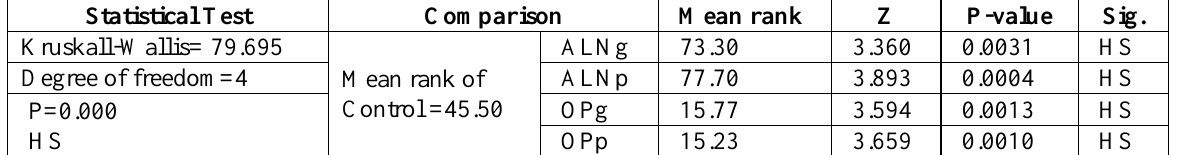
Table 4: Dun test for multiple comparisons of subgroups with control for salivary OPG concentration.